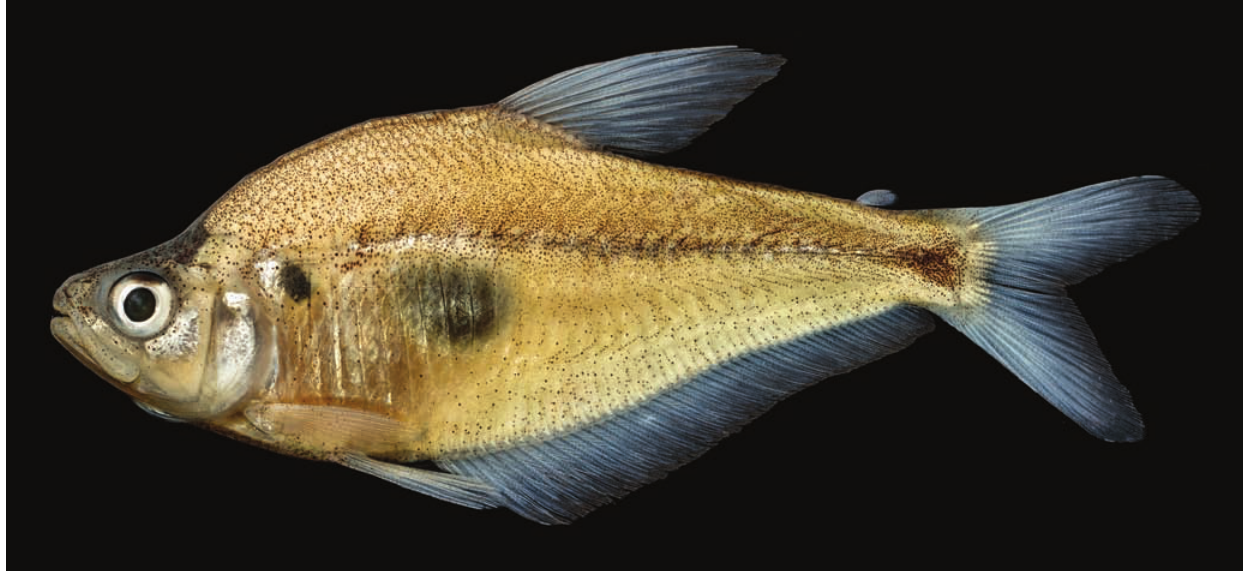
Fig. 25. Charax stenopterus , MZUSP 19919, male, 75 mm SL, Brazil, Rio Grande do Sul, Marquês de Souza, rio Forqueta, rio Jacuí